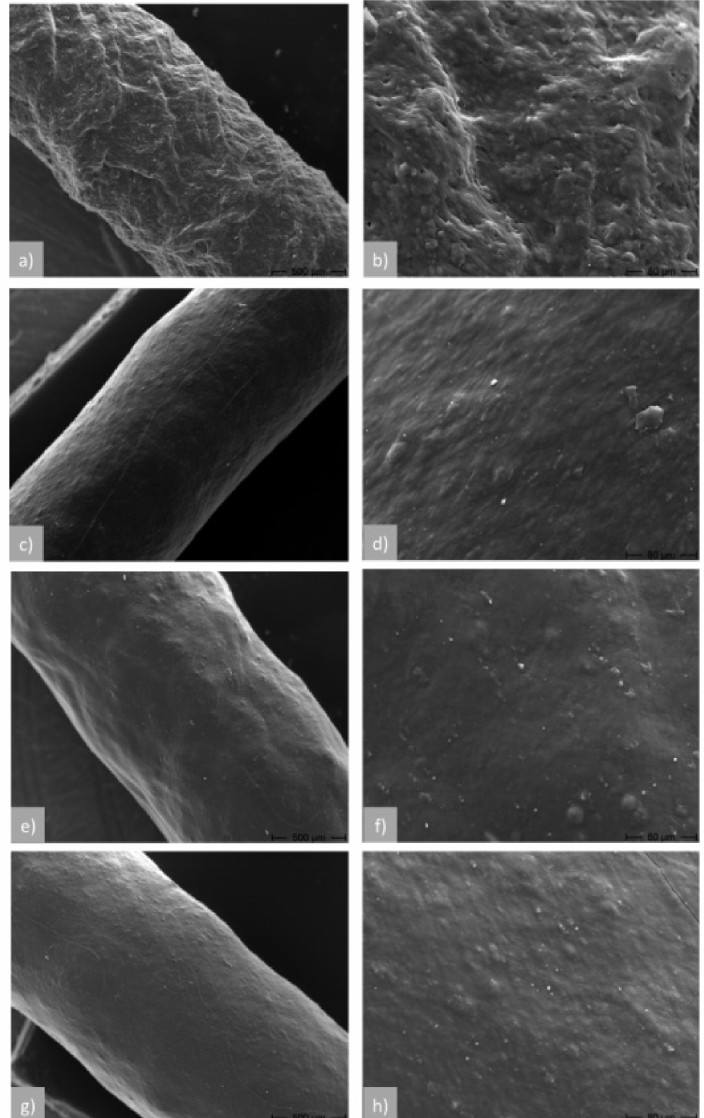
Figure 4. Surface of rice instant pasta processed at variable moisture content and screw speed: ( a , b ) 28%, 60 rpm; ( c , d ) 30%, 60 rpm; ( e , f ) 30%, 80 rpm; ( g , h ) 32%, 100 rpm; magnifications × 100 (left column) and × 600 (right